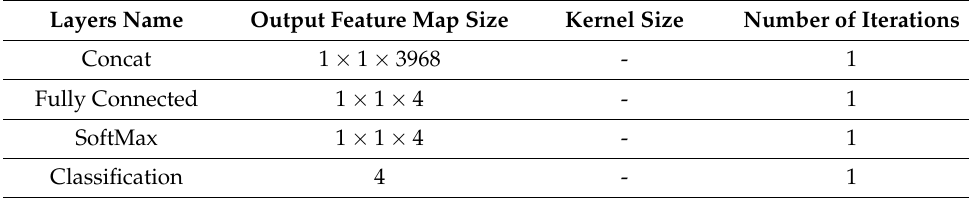
Table 4. Layer configuration details of